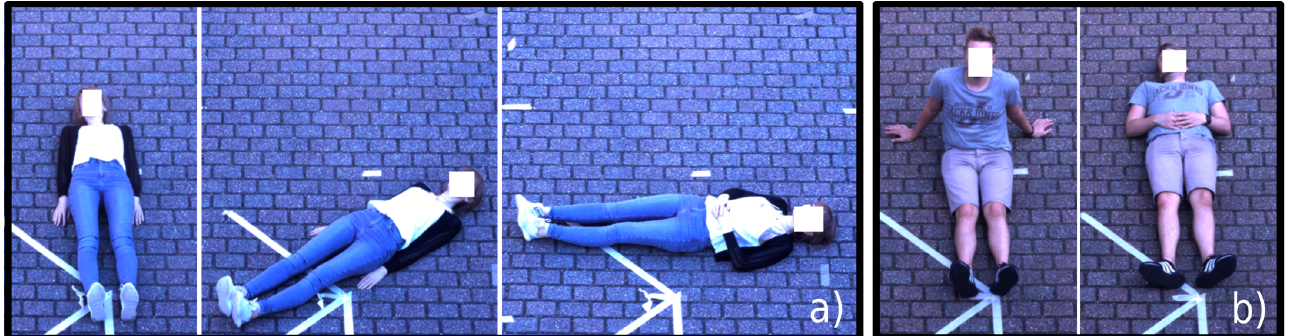
Figure 5. ( a ) Laying positions seen from different angles between the longitudinal axis of the human body and the cameras (0°, 45°, and 90° clockwise); ( b ) sitting and laying positions in a 0° body sagittal plan rotation toward the camera.